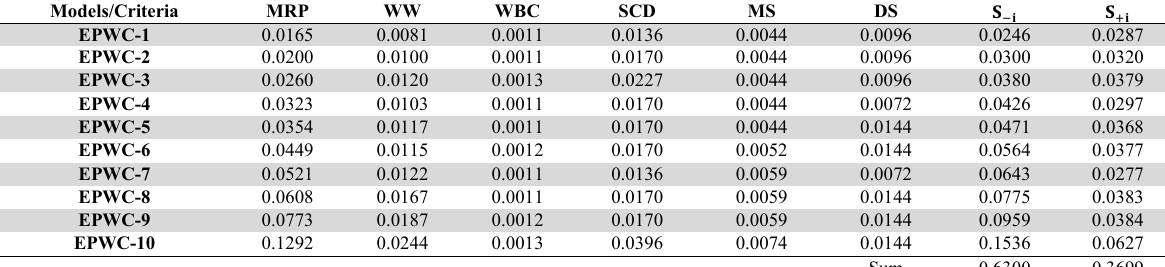
Weighted Normalized Matrix for EPWC selection